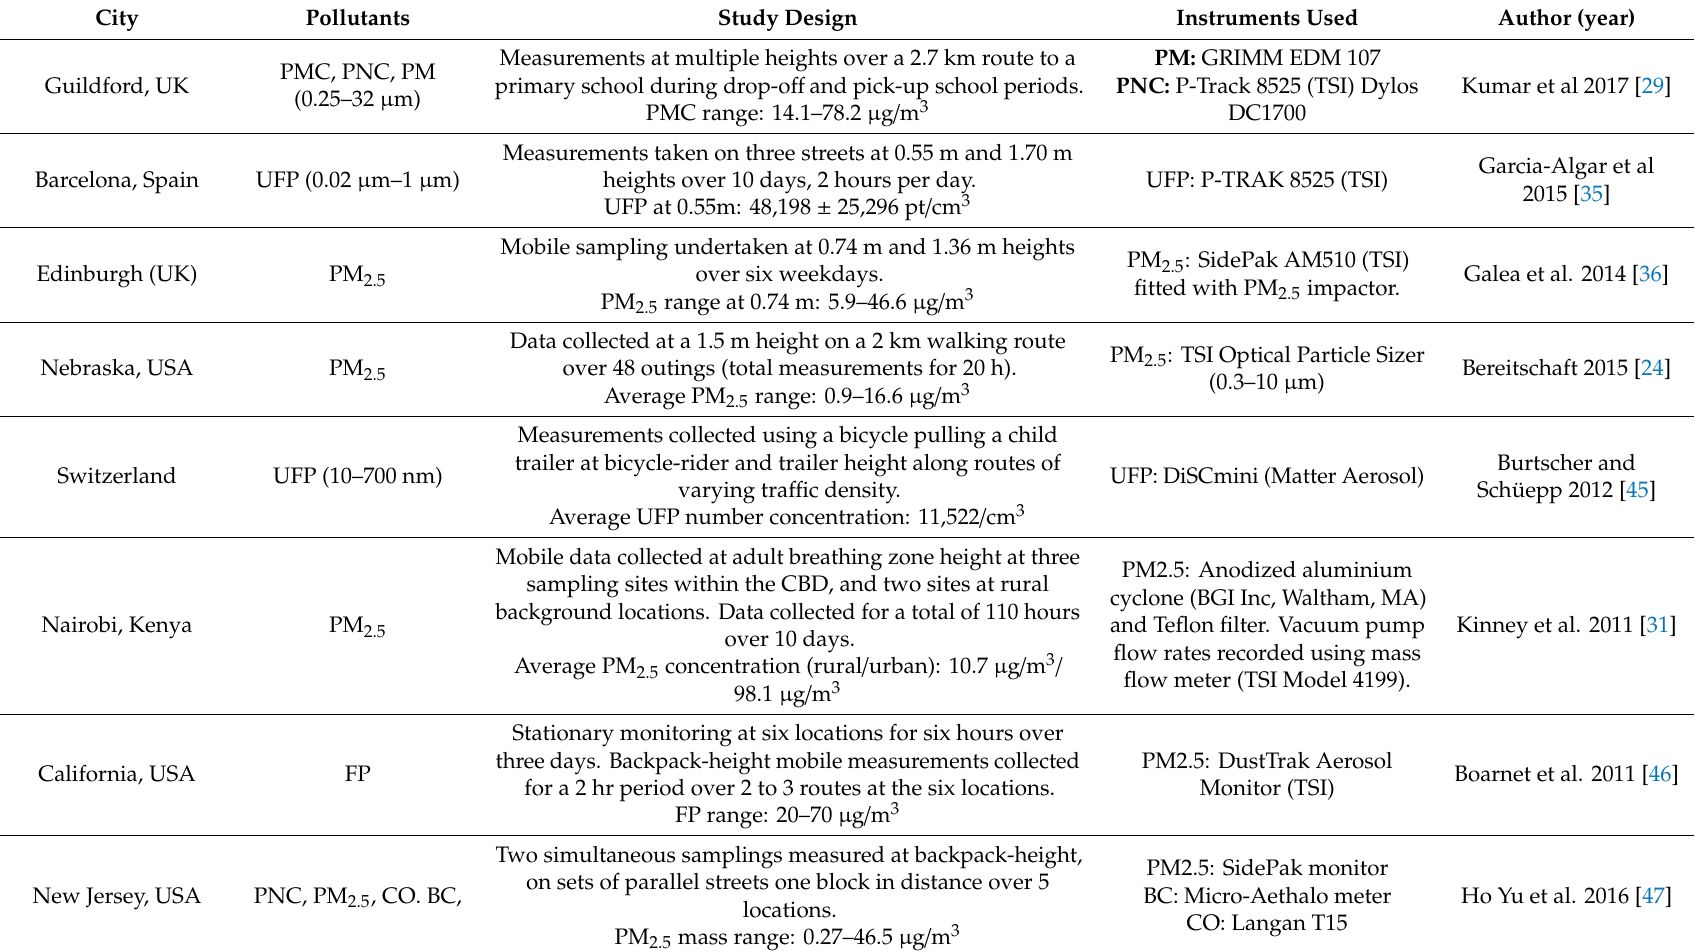
Table 1. Summary of relevant studies investigating PM 2.5 roadside